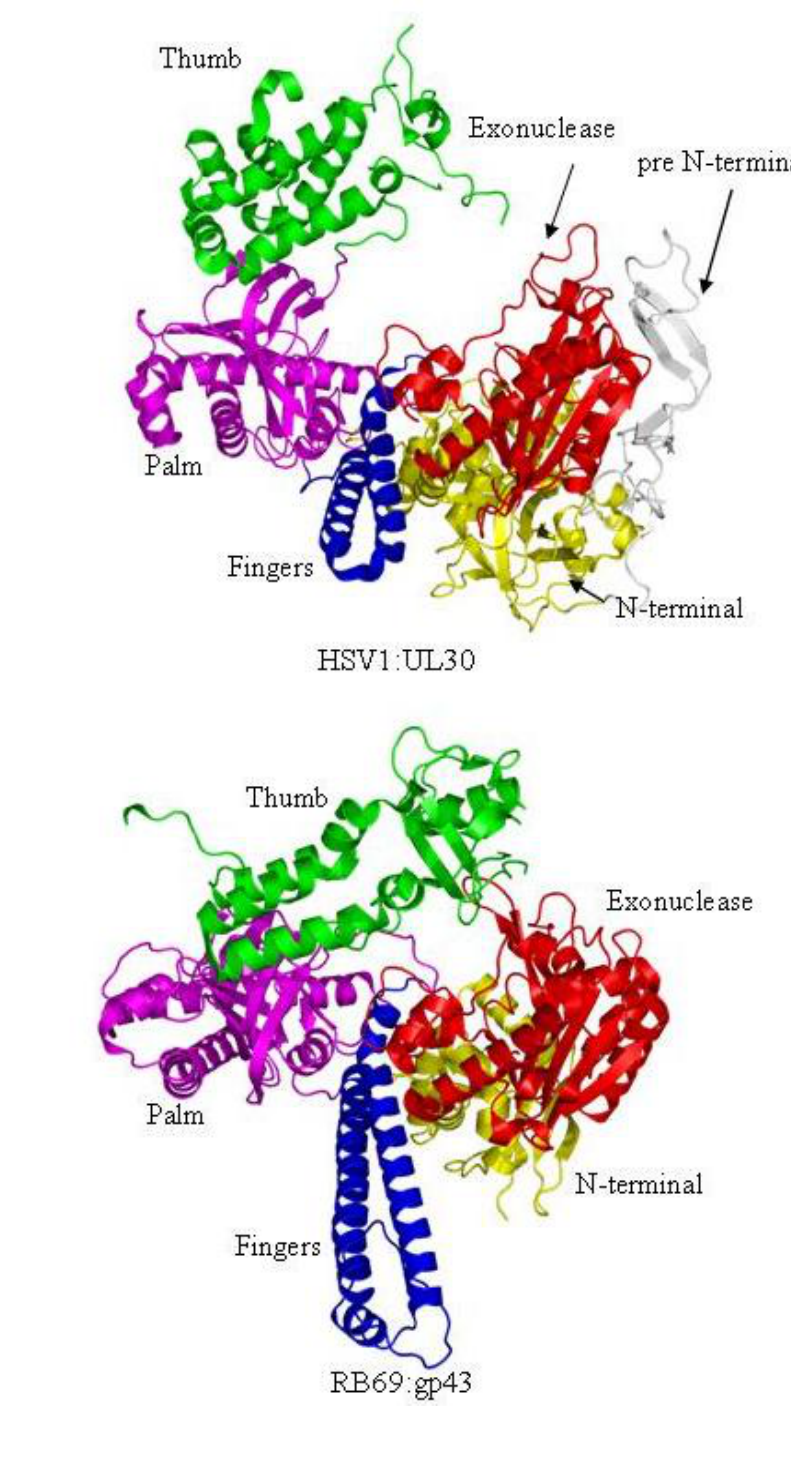
Figure 1. ( a ) Domain structure of HSV1 UL30 (pdb 2GV9) [9]. The pre N-terminal domain is shown in white, the N-terminal domain is yellow, the exonuclease domain is red, the palm domain is magenta, the fingers domain is blue and the thumb domain is green. ( b ) The structure of the RB69gp43 apo form (pdb file 1IH7) [15]. Both structures show the fingers subdomain the open conformation. Images were generated using Pymol